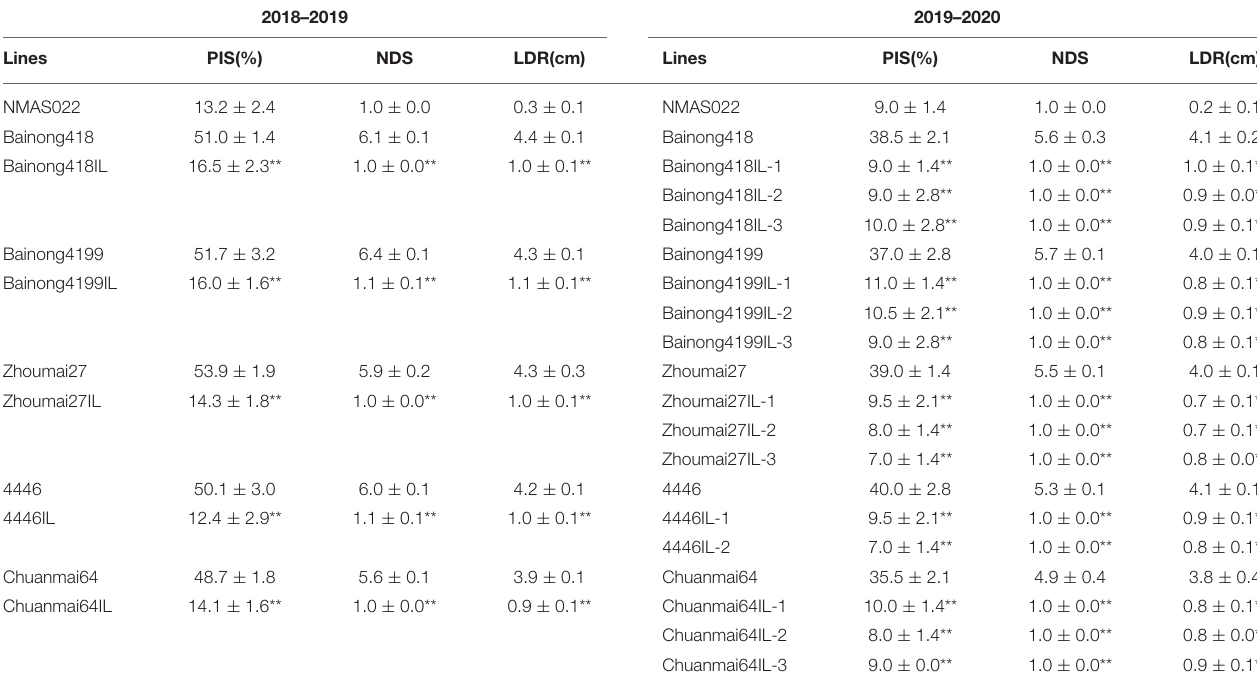
** indicate significance at P = 0.01, compared with the respective recipients. Comparison of the introgression lines with NMAS022 revealed significant differences only for LDR, which was not shown in the table.